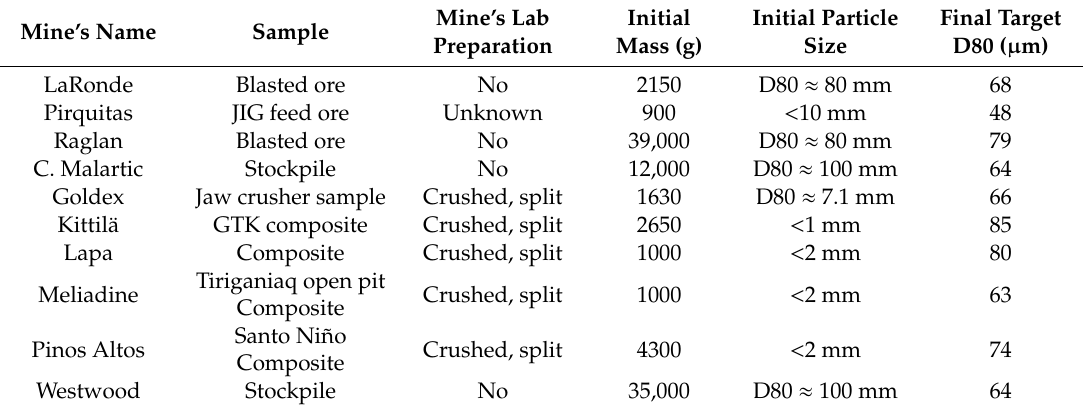
Table A1. Initial sample description and final D80 desired.